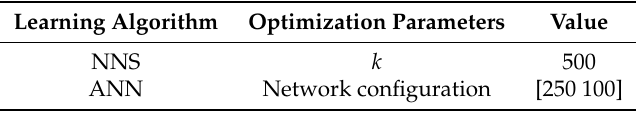
Table 2. Optimization settings for different learning algorithms. Network configuration describes the number of neurons in the first and second hidden layer. k = the number of neighbors, NNS = Nearest Neighbor Search and ANN = Artificial Neural